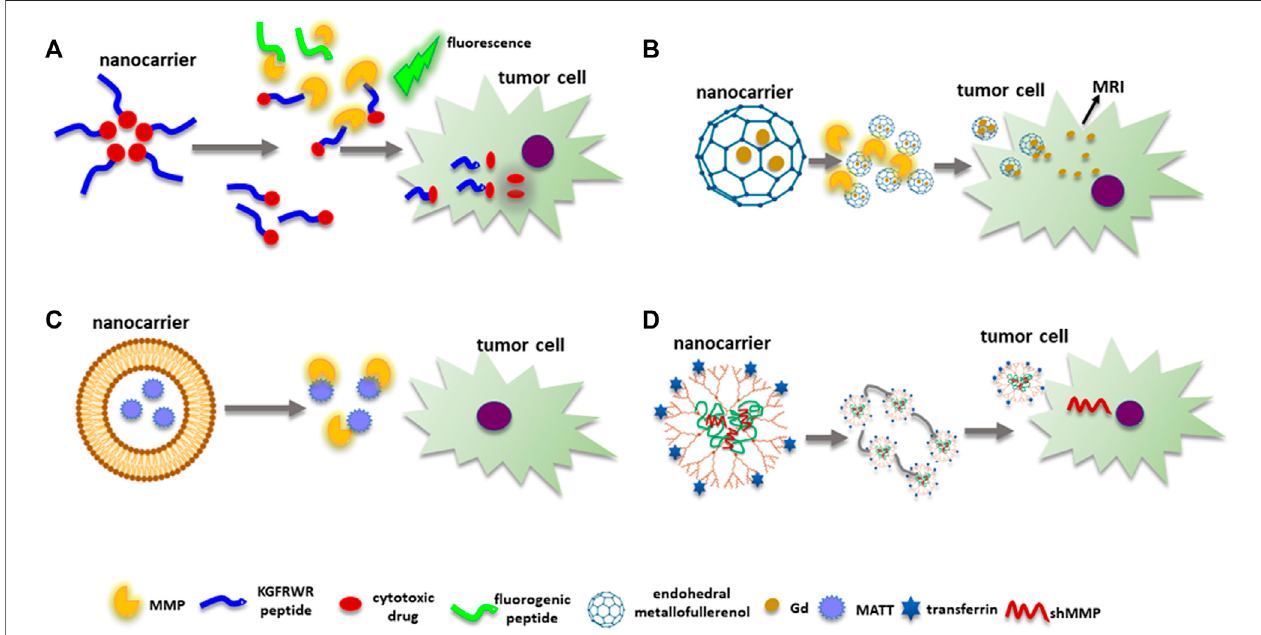
FIGURE 7 | MMPs as targets for nanomedicine. (A) The KGFRWR peptide and DOX form a nano fi ber. The peptide inhibits MMPs ’ enzymatic activity, while DOX hascytotoxiceffects.AnMMPsubstratewith fl uorogeniccapacitiesisalsousedtoquantifyMMPsenzymaticactivity. (B) MetallofullerenolNPsallostericallyinhibitMMPs ’ enzymaticactivity.Endohedral Gd@C82(OH)22carriesGd insidetoavoidtoxic effects allowing MRIimages. (C) NanocarrierscandeliversMMPIssuchasMATTnextto the neoplastic cells avoiding toxic side effects. (D) Genetic material to inhibit MMPs ’ expression can be delivered by nanocarriers with speci fi c tumor